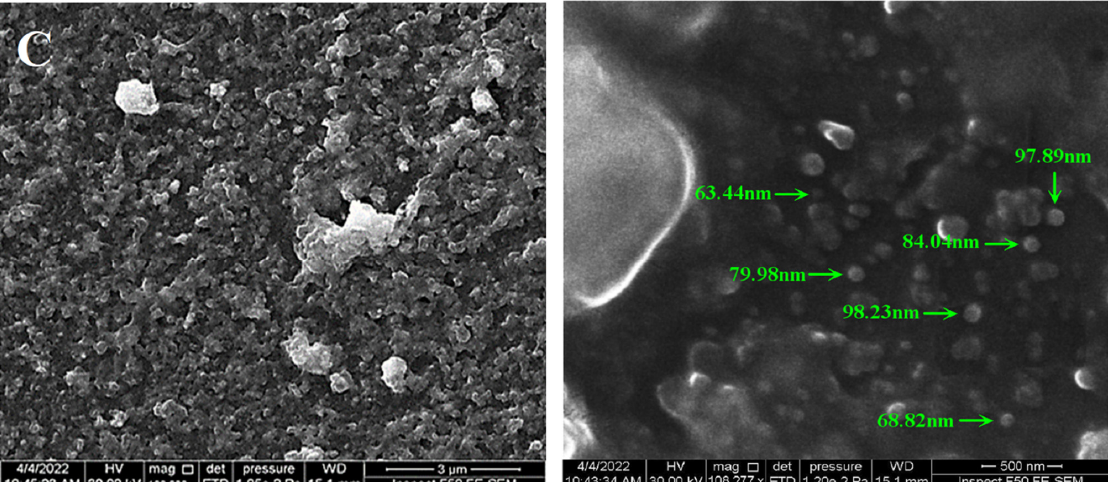
Figure 9. SEM images (left panels; scale bar 3 µ m) and particle size measurements (right panels; scale bar 500 nm). ( A ) AgNPs, ( B ) AgNPs-PEG, and ( C ) AgNPs-PEG-CIP.